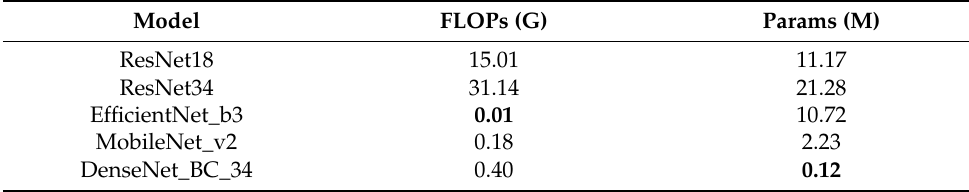
Table A2. FLOPs and Params of different